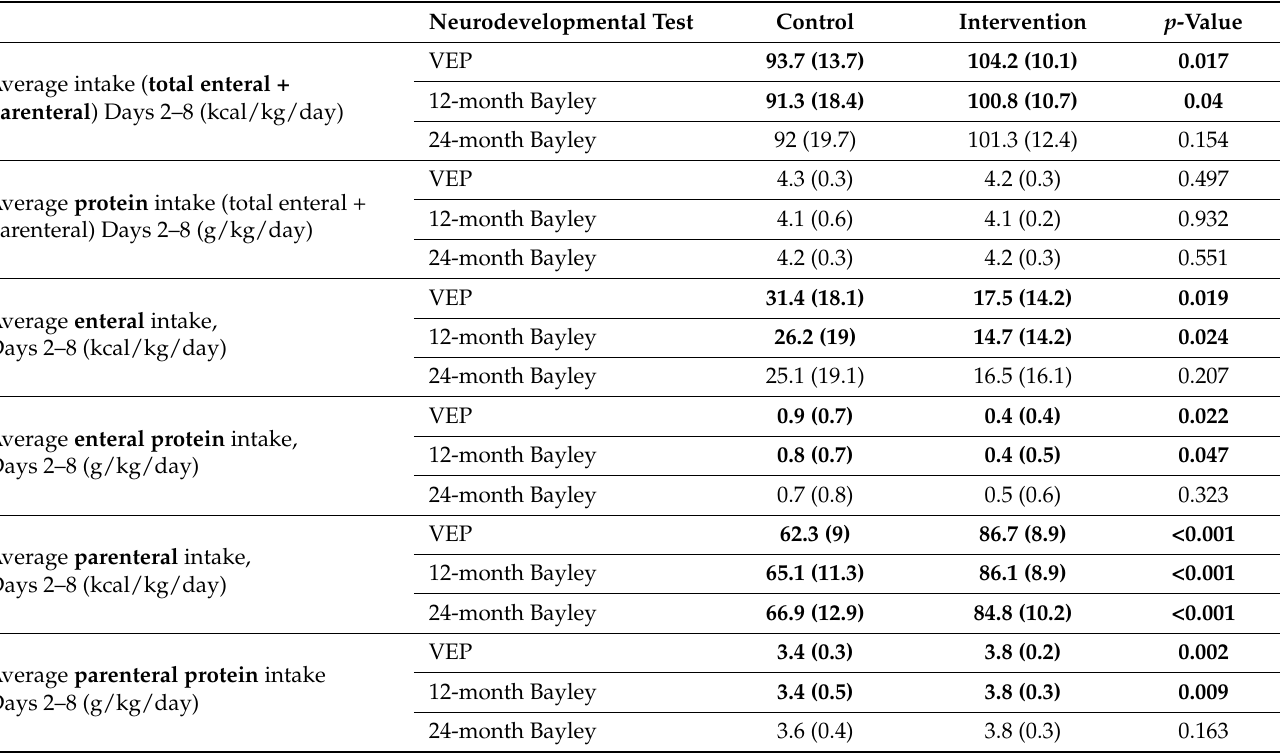
Table 2. Inpatient nutritional variables by neurodevelopmental follow-up group. Results displayed as mean (SD).